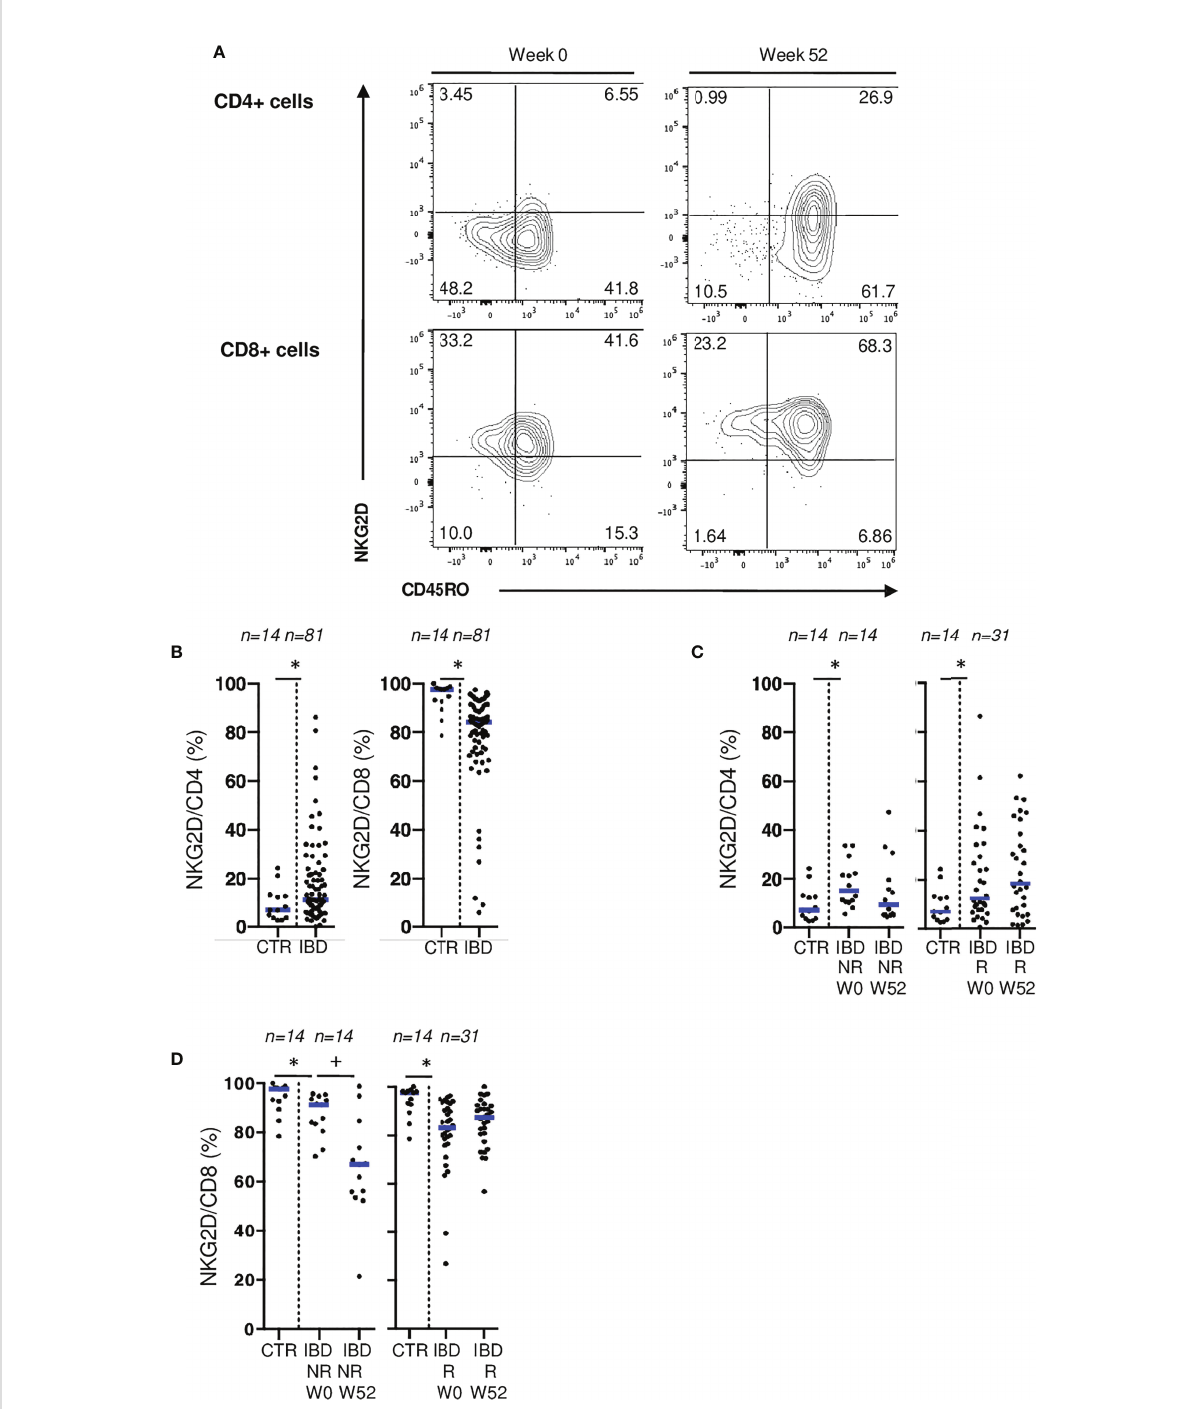
FIGURE 6 NKG2D expression on mucosal T cells is associated with IBD disease activity. (A) Gating strategy for CD45RO and NKG2D stainings in fl ow cytometry. (B) Comparison of mucosal rates of CD4 and CD8 T cells expressing NKG2D between controls and patients from the ELYP cohort at week 0. (C) Evolution of mucosal rate of CD8 T cells expressing NKG2D rates in IBD patients from the ELYP cohort without or with endoscopic response to biotherapy. (D) Evolution of mucosal rate of CD4 T cells expressing NKG2D rates in IBD patients from the ELYP cohort without or with endoscopic response to biotherapy. CD= Crohn ’ s Disease, CTR= Control, IBD= In fl ammatory Bowel Disease, NR= Non Responders, R= Responders. *p < 0.05 Mann Whitney Test; +: p < 0.05 Wilcoxon Paired